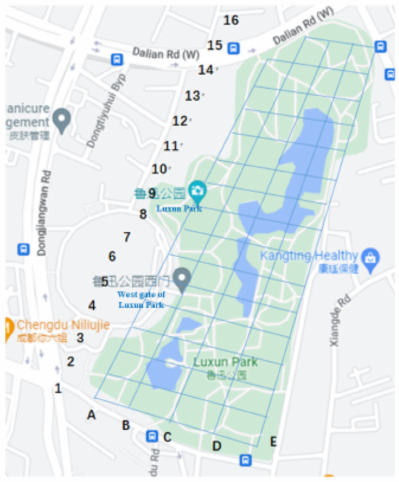
Figure 6. Distribution of monitoring